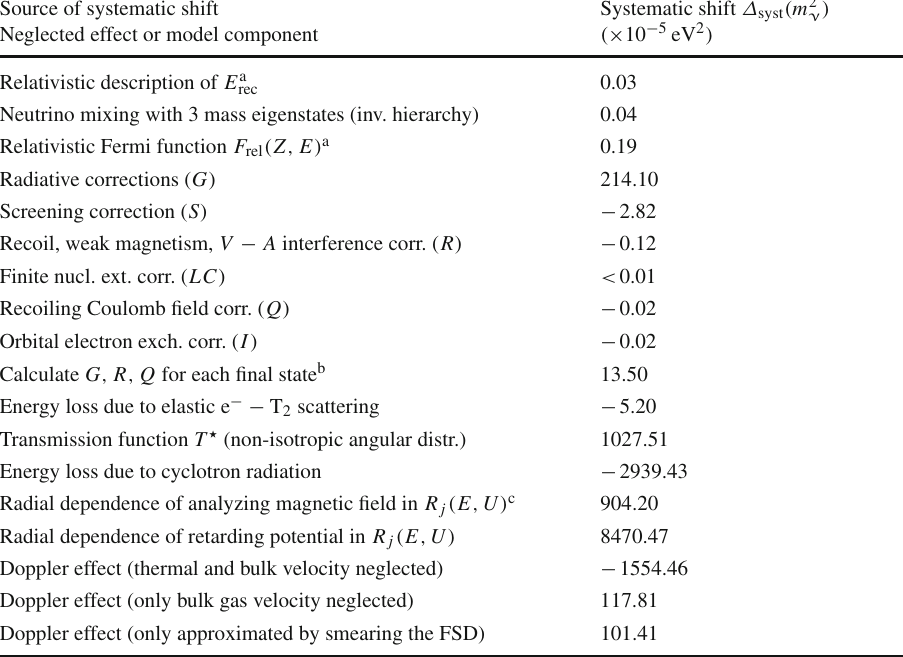
theoretical and experimental model corrections on the measured squared neutrino mass m 2 ν , if neglected or approximated. The analysis energy window is restricted to